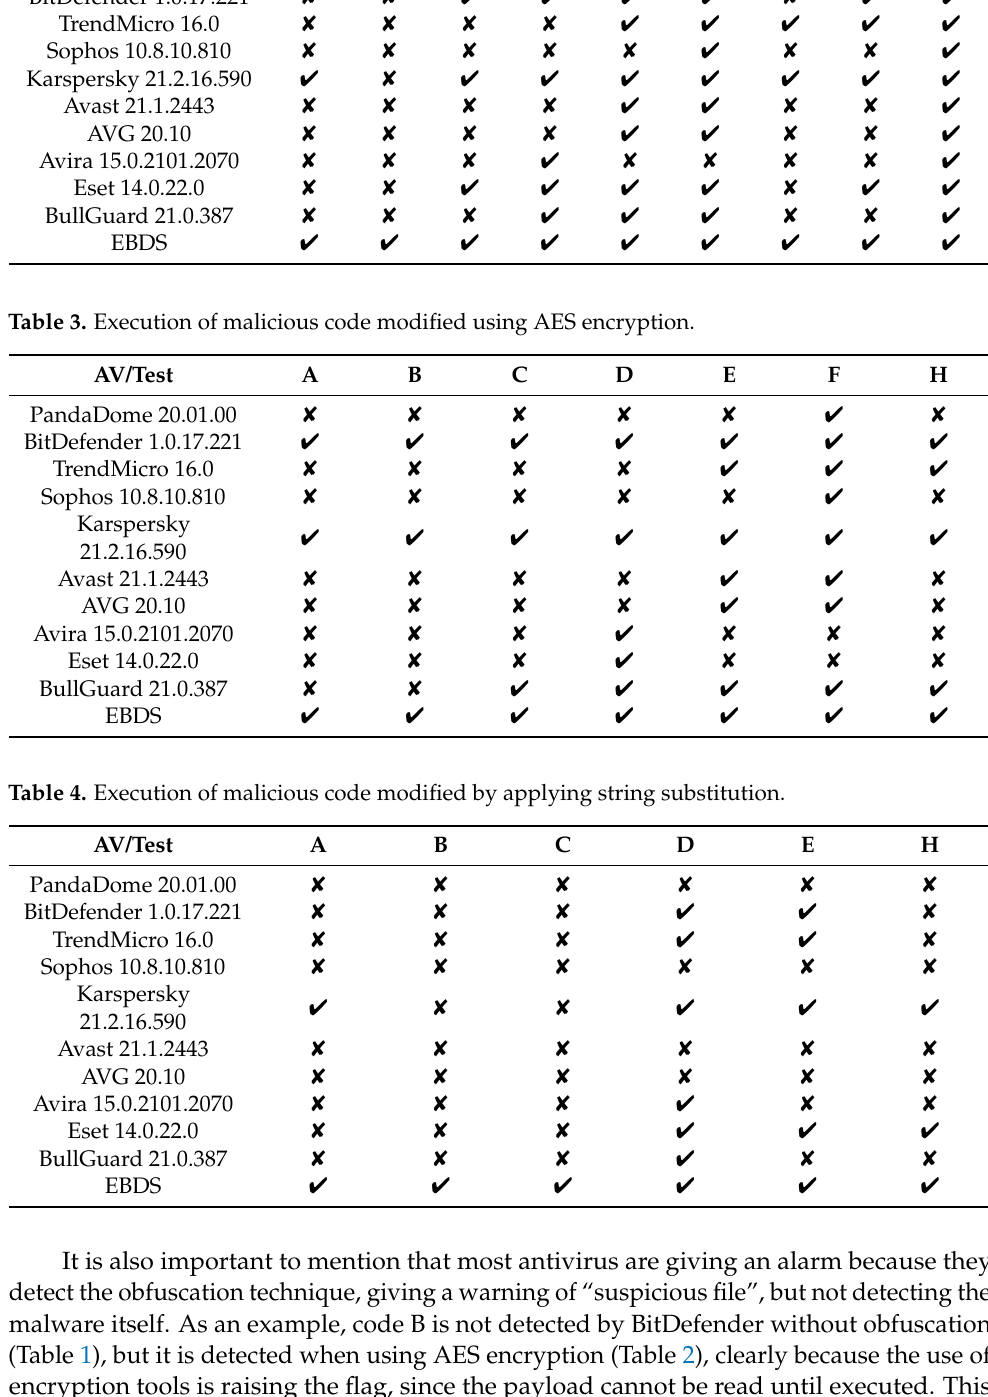
Table 2. Execution of malicious code without any encryption method. AV/Test A B C D E F G H PandaDome 20.01.00 BitDefender 1.0.17.221 TrendMicro 16.0 Sophos 10.8.10.810